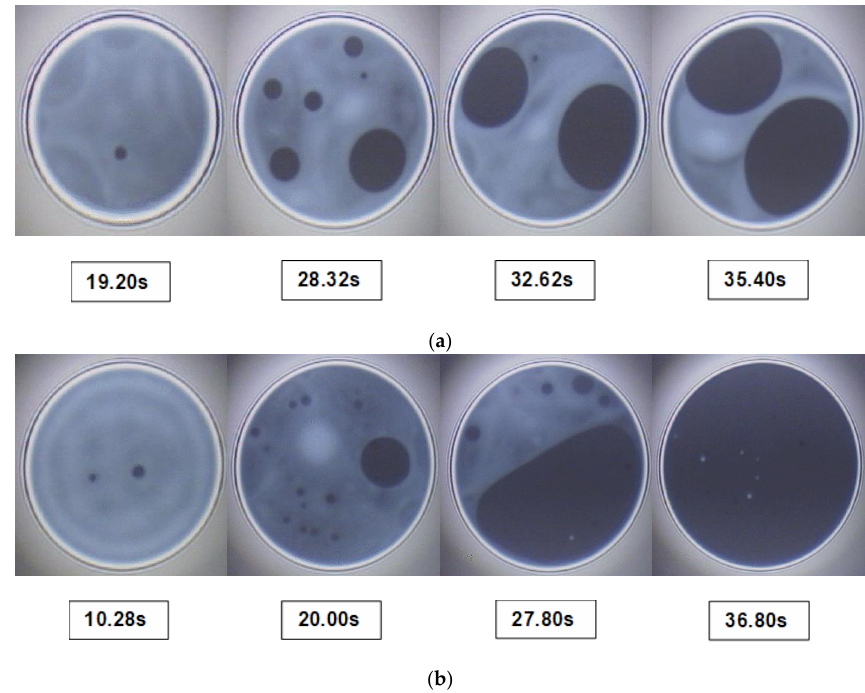
Figure 7. Evaluation of drainage of foam film stabilized for total surfactant concentration 3.0 × 10 −5 mol/L of the mixture. ( a ) CTAC:C 12 E 5 = 1:10. The foam films drain and rupture before the onset of black films. There are no white dots. ( b ) CTAC:C 12 E 5 = 10:1. Two regions of thickness and white dots are formed, but their number is notably less than in the case in Figure 6.